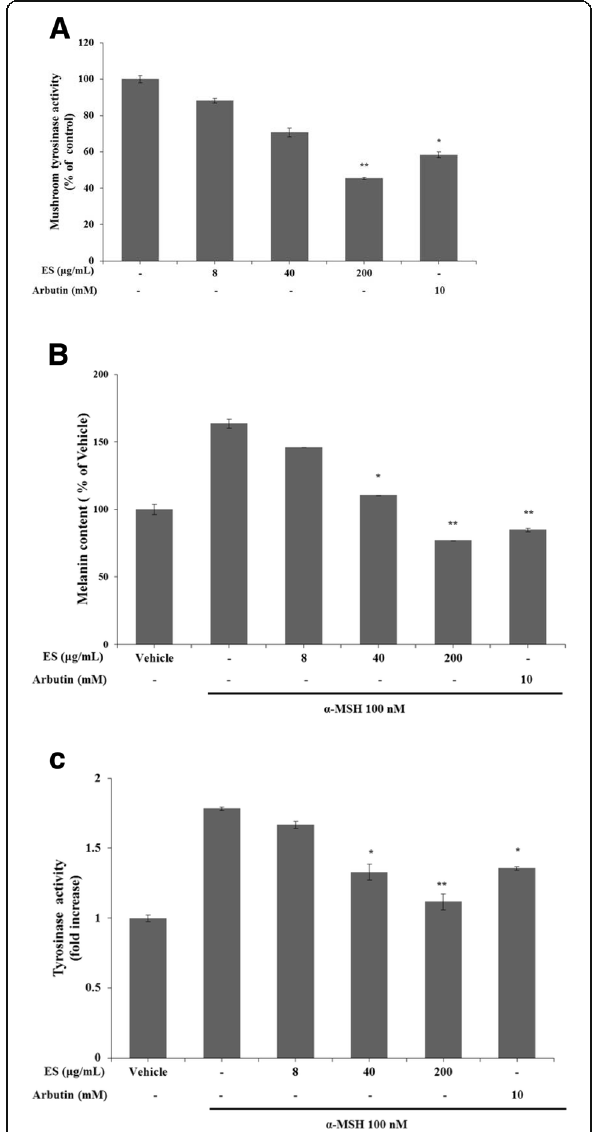
Fig. 3 Inhibitory effect of ES extract on mushroom tyrosinase activity, B16F10 melanin content and intracellular tyrosinase activity. a Different concentrations of the ES extract (8, 40, 200 μ g/ml) or arbutin (10 mM) was incubated with the same units of mushroom tyrosinase. Following incubation, the amount of dopachrome produced was determined at 490 nm. b and c B16F10 melanoma cells were stimulated with α -MSH (100 nM) for 48 h, and then the melanin content or intracellular tyrosinase activity were measured after treatment with various concentrations of the ES extract (8, 40,200 μ g/ml) or arbutin (10 mM) for another 24 h. Results are represented as percentages of control, and data are presented as mean±S.D. for three separate experiments. Values are significantly different by comparison with control. *: p <0.05, **: p <0.01 α -MSH treatment